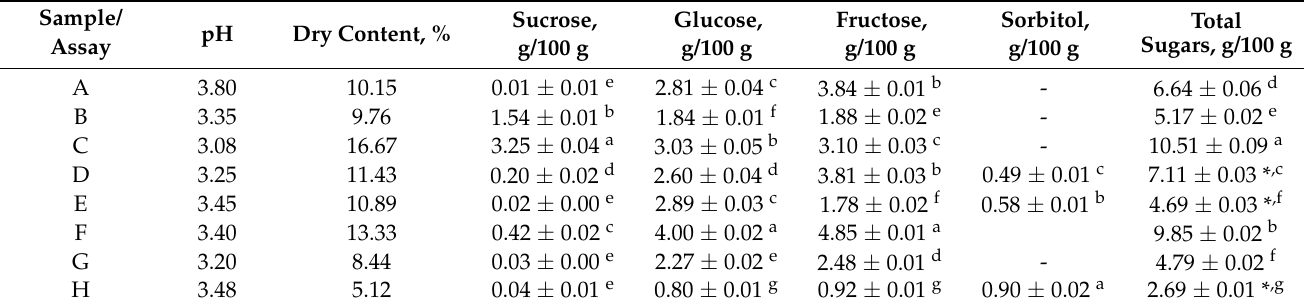
Table 1. Physicochemical characteristics, individual and total sugar content of fruit juices prior to in vitro digestion **. Sample/ Assay